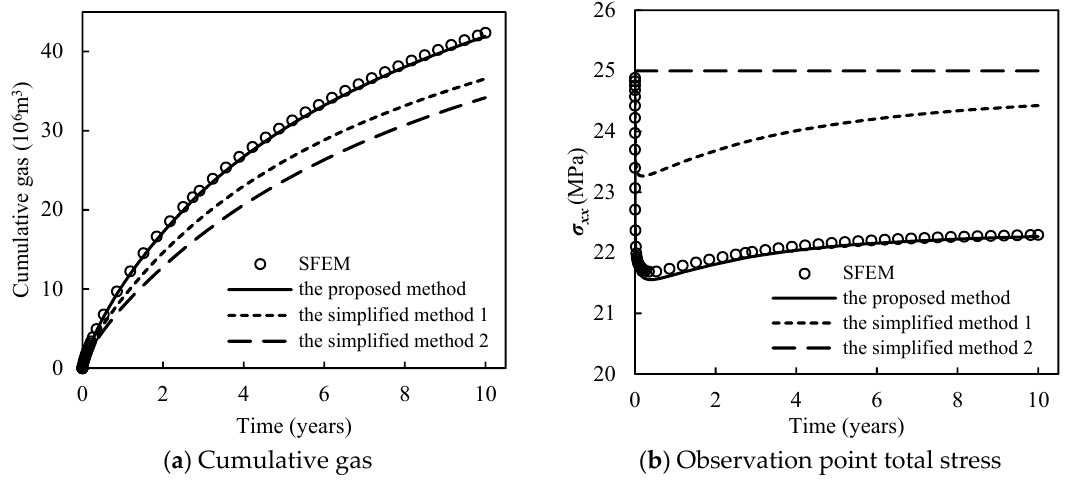
Figure 10. Comparisons of cumulative gas and observation point total stress obtained from different methods.